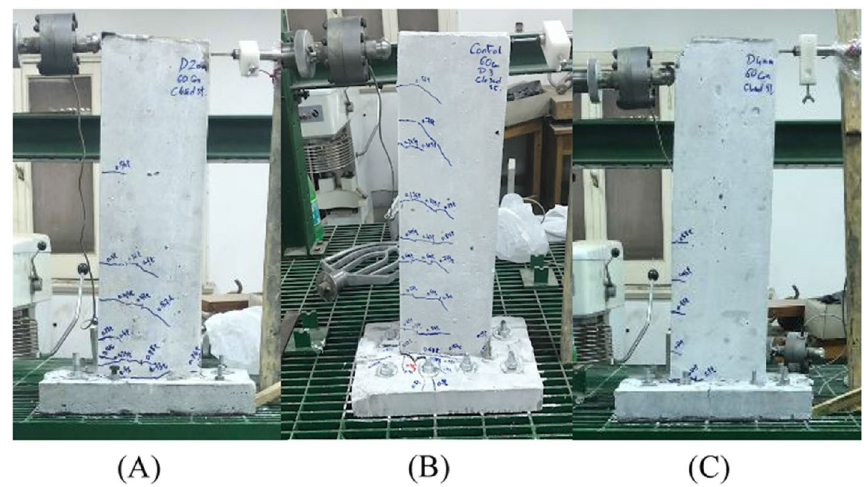
Fig. 7 Walls with varying vertical RFT from A D